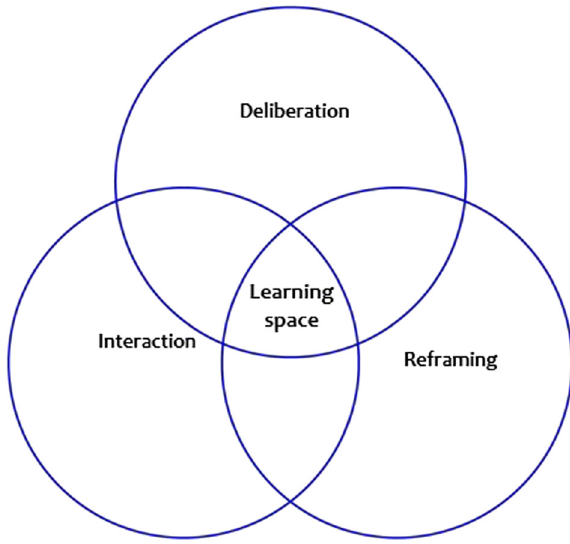
Fig. 1 Process of social learning. Shown as interlinkages of interaction, deliberation and reframing (source